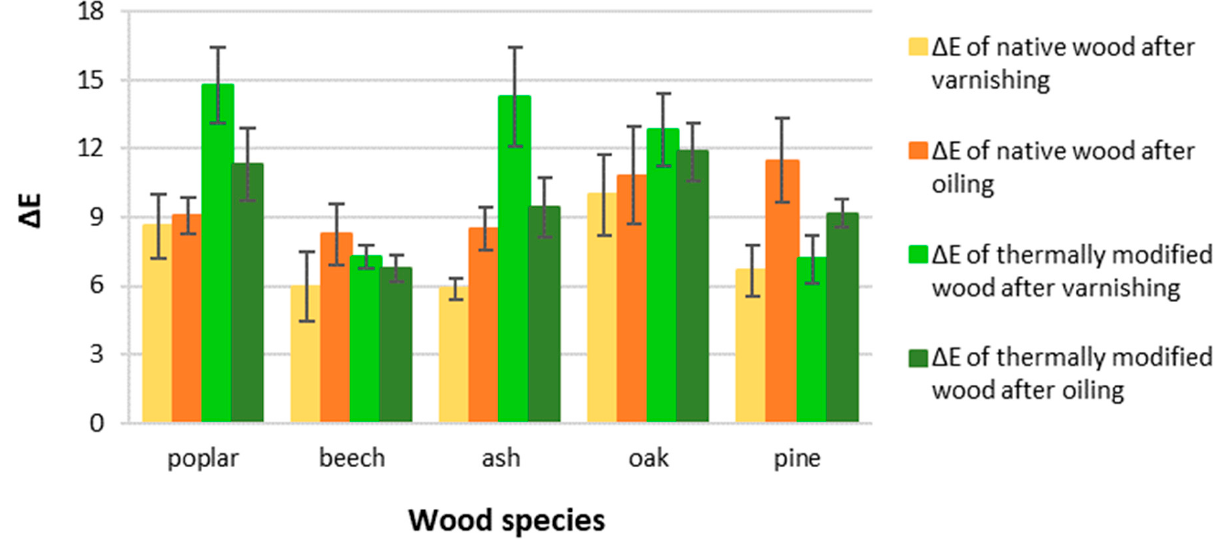
∆ E of varnished, oiled native and thermally modified Figure 5. The total colour difference Δ E of varnished, oiled native and thermally modified wood. Figure 5. The total colour difference